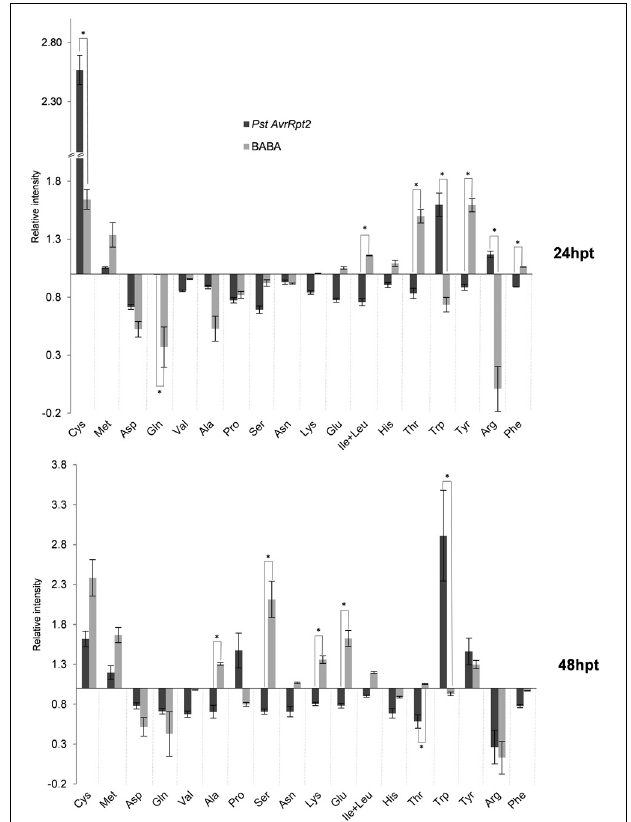
FIGURE 4 | Amino acid profile of plants primed with BABA and PstAvrRpt2 , respectively. The abundance of each amino acid was calculated as described for Figure 2 . Col-0 plants, 4–5 week-old, were harvested at 24 and 48hpt. Asterisks represent statistically significant differences (Wilcoxon Mann–Whitney test, p < 0 . 05, n = 6). Data represent average of three independent